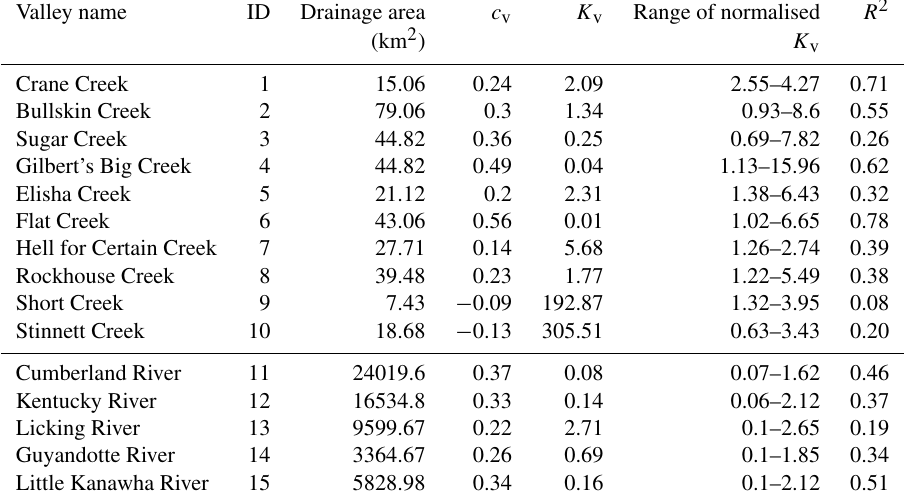
Table 2. Width–area analysis for rivers in the Cumberland and Allegheny plateaus, Kentucky and West Virginia, USA. The ID of the valley correlates to the locations in Fig. 11. c v and K v are calculated from power-law fits to width and drainage area along each channel. Normalised K v is calculated using a reference value of c v = 0 . 21 for valleys 1–10 and c v = 0.3 for valleys 11–15. The units of K v vary depending on the value of c v : they are mkm − 2 c v . The drainage area is reported in km 2